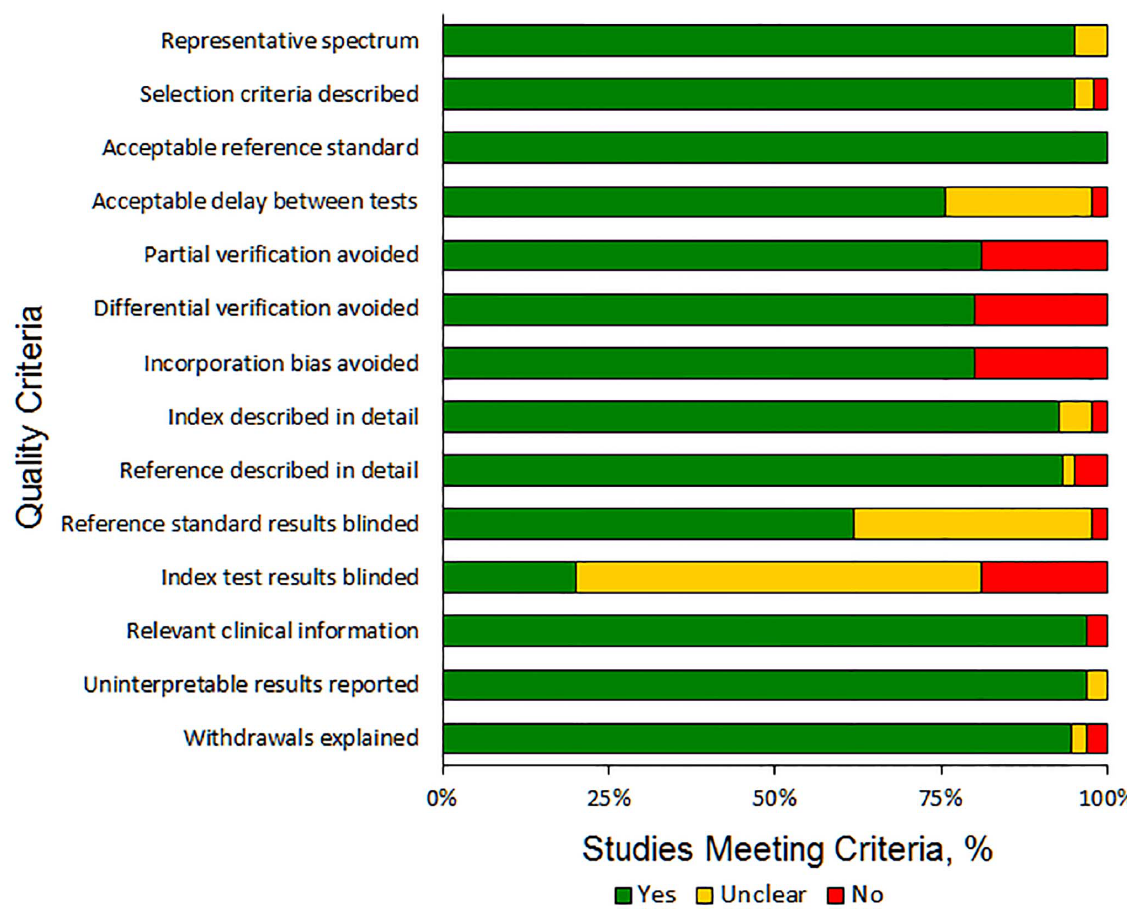
Figure 2. Quality Assessment of Diagnostic Accuracy Studies (QUADAS) assessments of the quality of included studies.